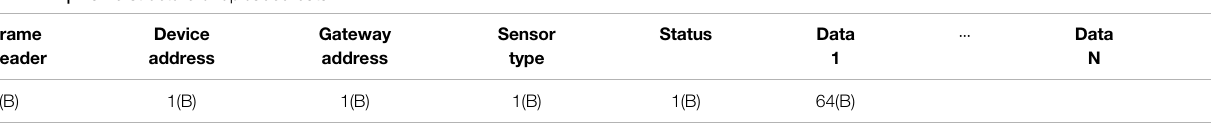
TABLE 1 | Frame structure of uploaded data.